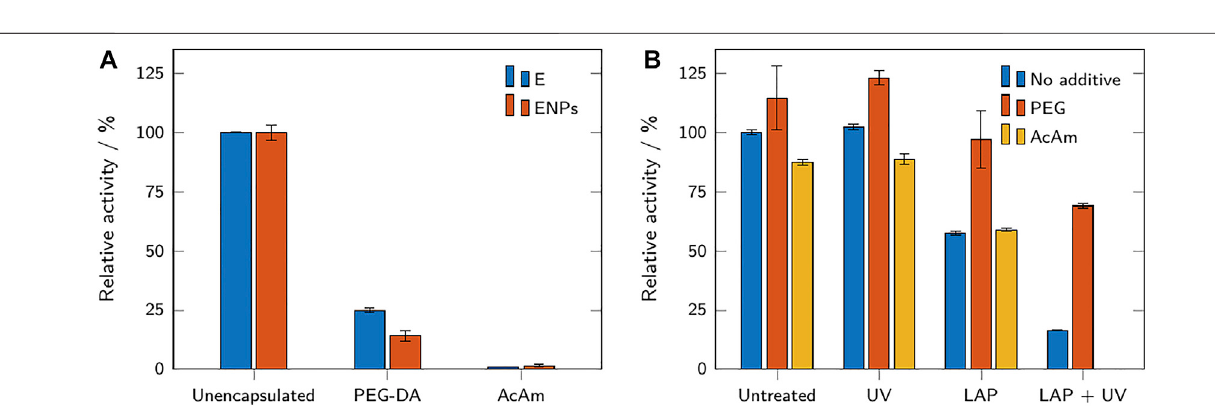
Frontiers in Bioengineering and Biotechnology |